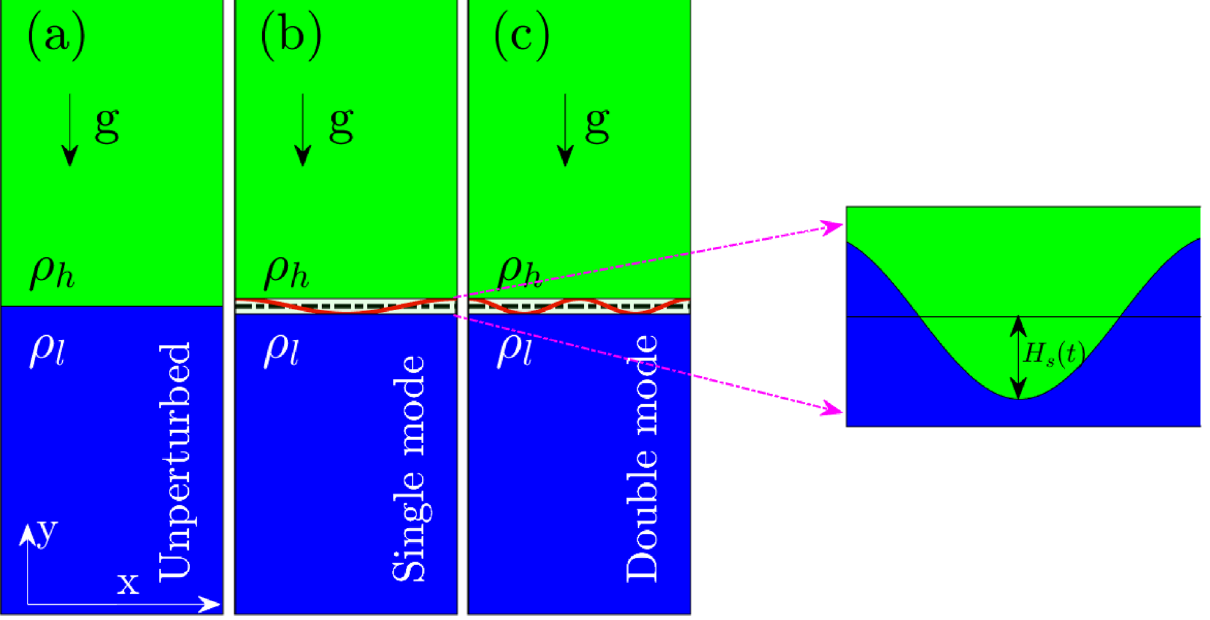
Figure 8. Schematic diagram used to study RTI in 2D (( 0, L x ) , ( 0, L y )) MD simulations using LAMMPS. ( a ) Initial system configuration with heavy fluid (density, ρ h ) on top of the light fluid (density, ρ l ). Single ( b ) and double ( c ) mode perturbation excitation at the interface between the heavy-light fluid (width = 100 a). The magnified view of the interface at the rightmost end shows the growth of the spike amplitude H s ( t ) of the single- mode initial sinusoidal perturbation. Particle parameters Rectangular configuration ( L y = 10 L x ) Square configuration Fig. 1 ( L x = L y